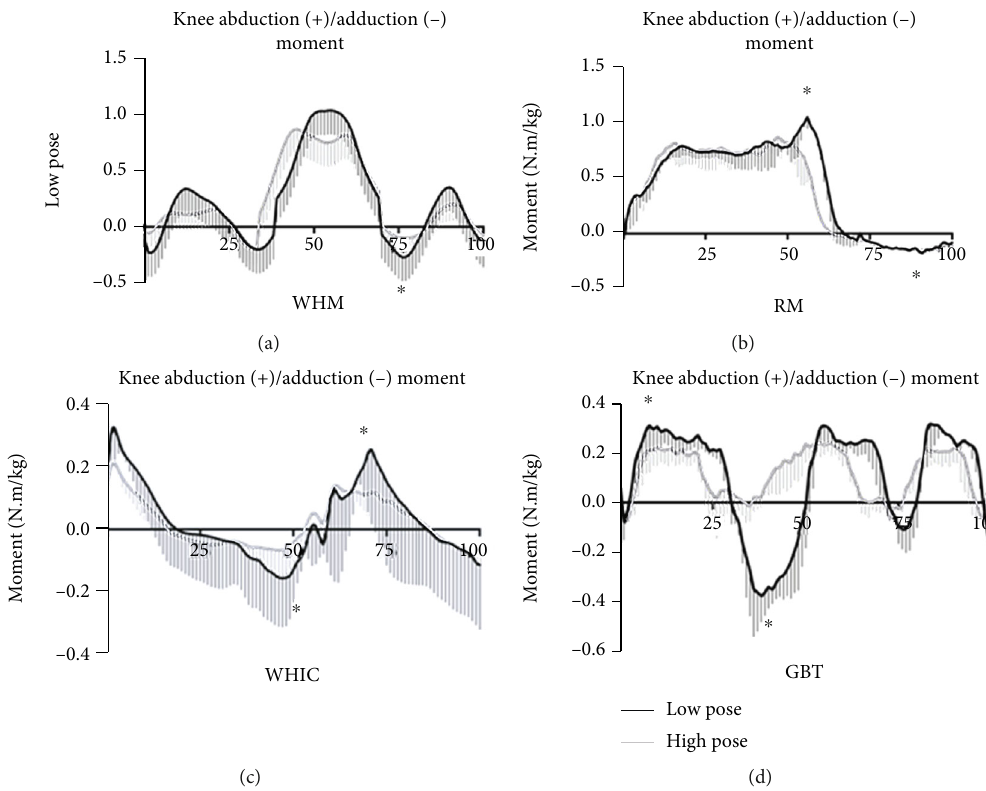
Figure 4: Joint moment at knee in frontal plane in high (black) and low (gray) pose for wild horse ’ s mane (WHM), repulse monkey (RM), wave-hand in cloud (WHIC), and grasp the bird ’ s tail (GBT) during one support phase ( N = 14 ). ∗ p < 0 : 05